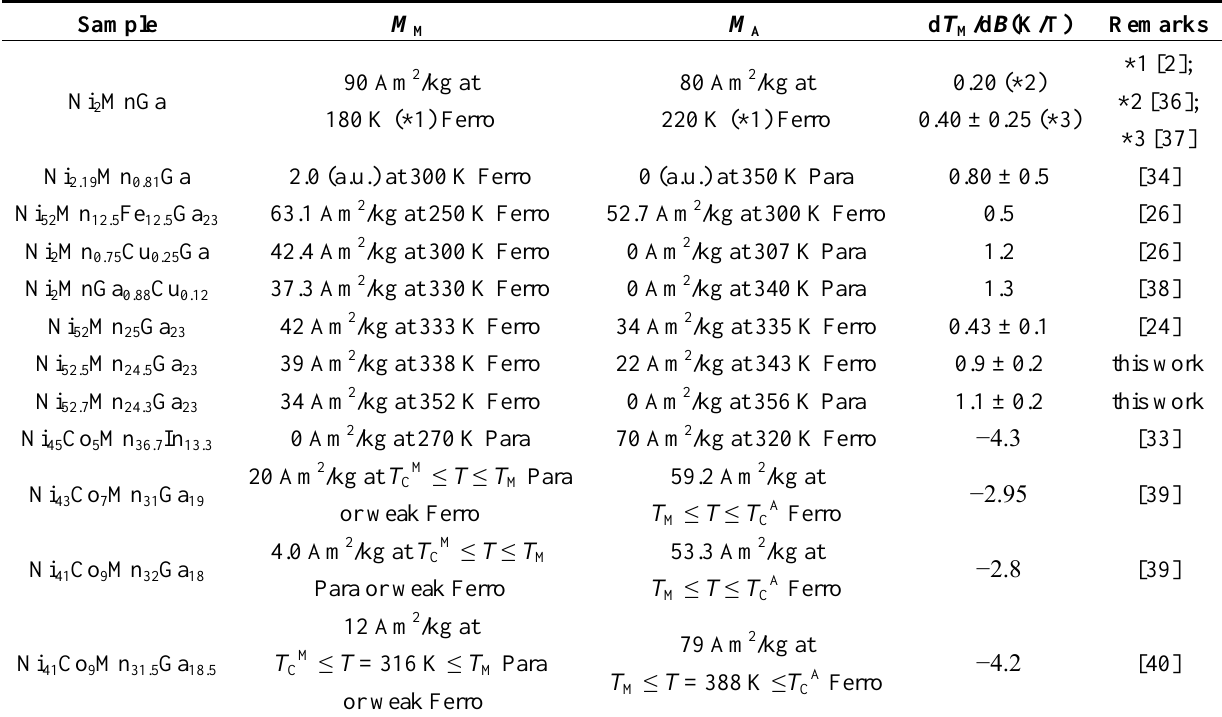
Table 1. Spontaneous magnetization and d T /d B in Heusler Ni MnGa type magnetic shape M 2 memory alloys. M and M indicate the spontaneous magnetizations in the martensite M A phase and austenite phases, respectively. Ferro and Para indicate the ferromagnetic and the paramagnetic phases, respectively. T CM indicates the Curie temperature in the martensite phase, and T CA indicates the Curie temperature in the austenite phase. The * symbols in this table (eg. *1) indicate the references as shown in Remarks